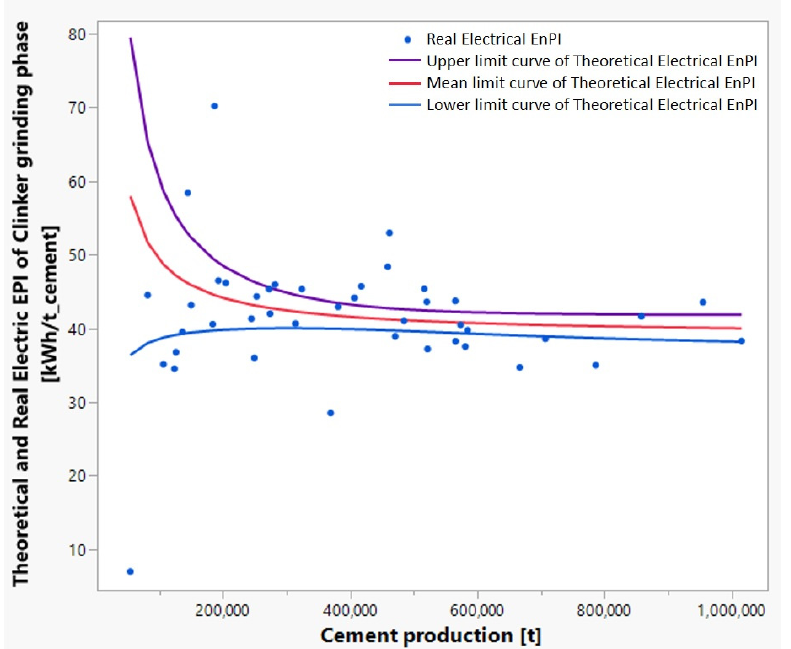
Energies 2021 , 14 , x FOR PEER REVIEW Figure 22. NACE 23.51: Theoretical and real electric EnPI of the clinker grinding phase. Table 4. NACE 23.51: Statistical parameters of linear regression: phase consumptions.